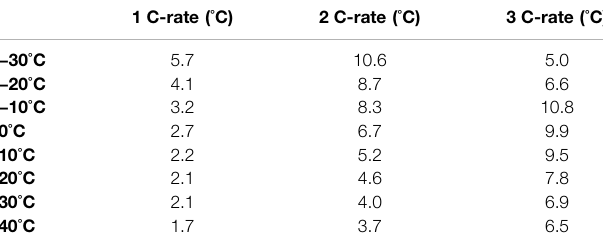
TABLE 3 | Average temperature change on battery